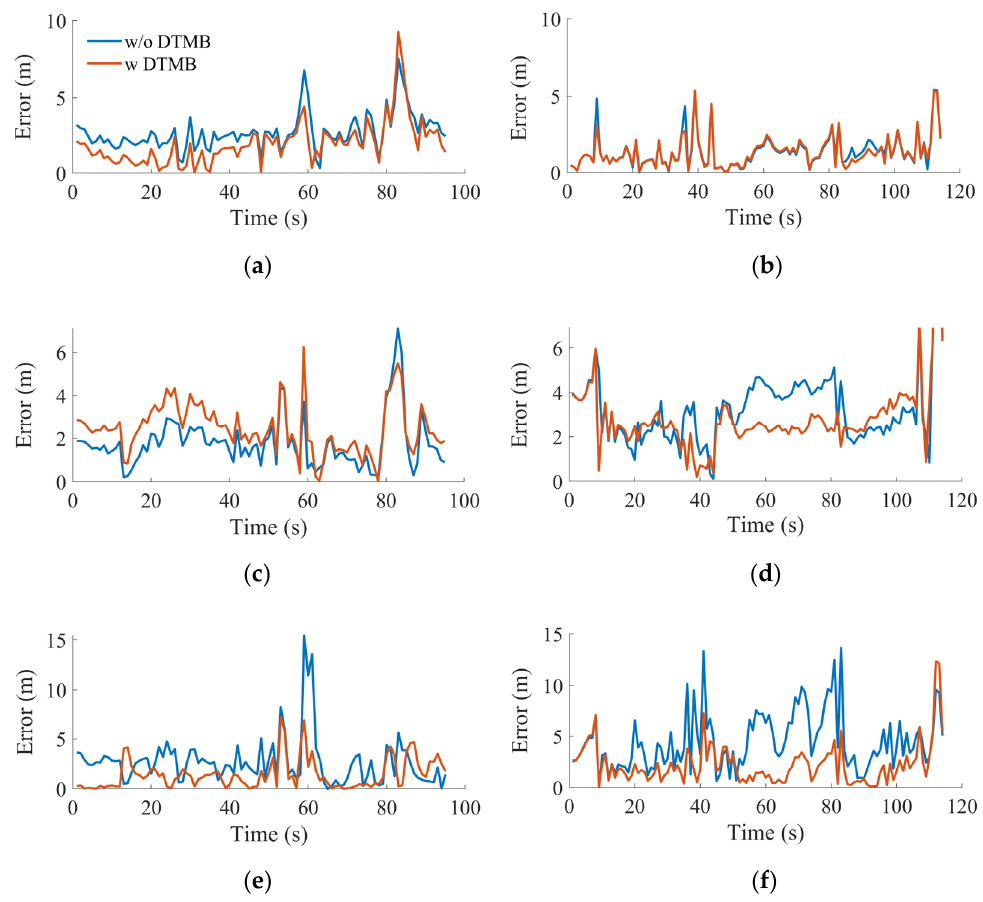
Figure 14. Absolute position error in terms of different directions. ( a ) Clockwise, east direction. ( b ) Counter-clockwise, east direction. ( c ) Clockwise, north direction. ( d ) Counter-clockwise, north direction. ( e ) Clockwise, up direction. ( f ) Counter-clockwise, up direction.